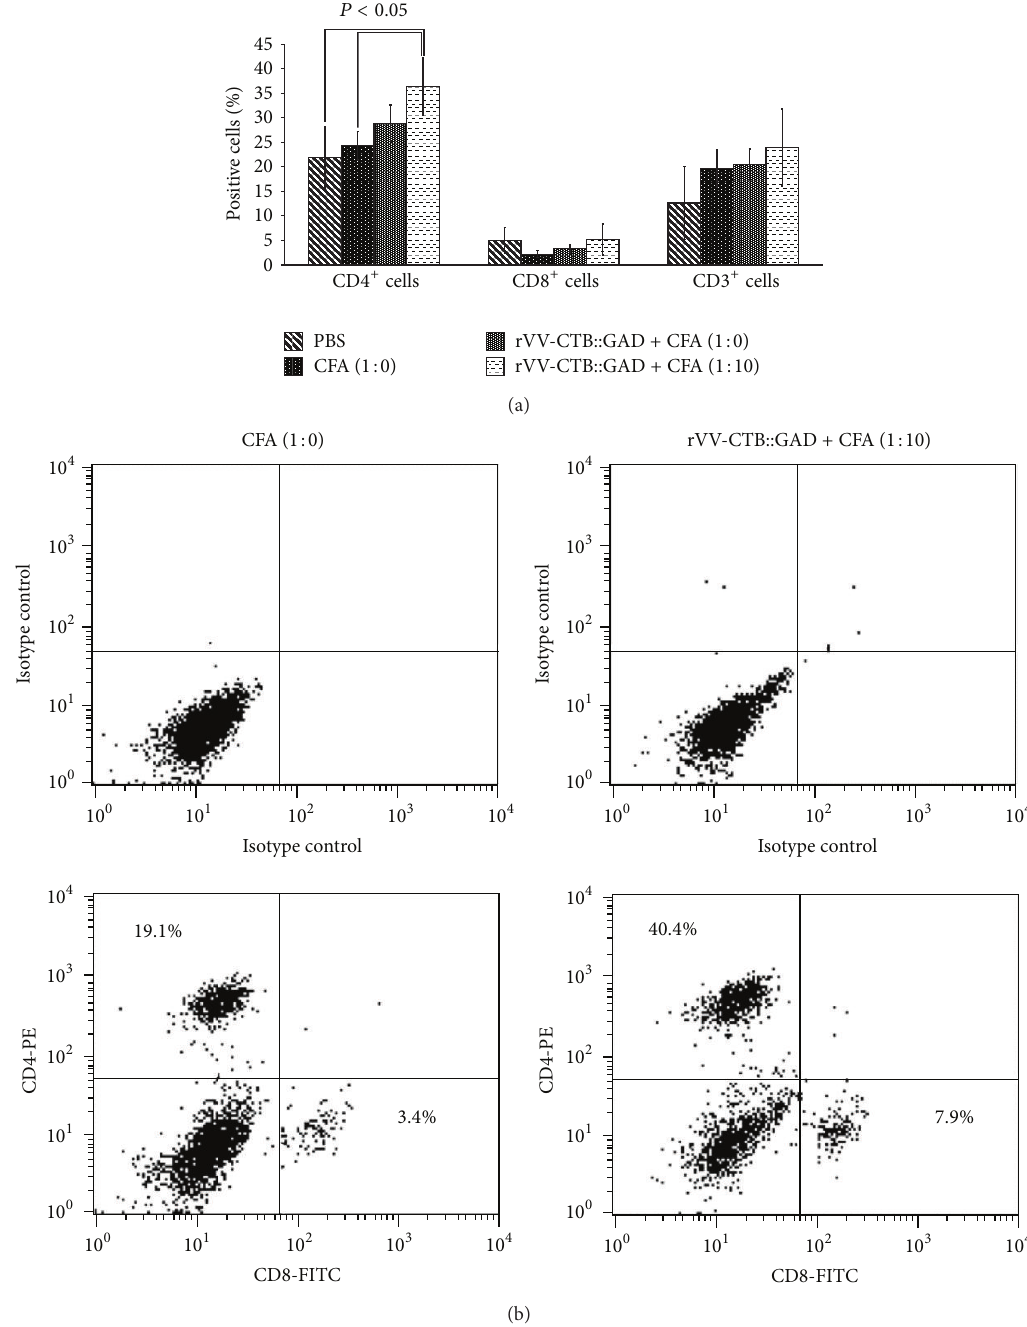
Figure 5: Analyses of splenocyte T-cell subsets. (a) Percentage of the CD3 + , CD4 + , and CD8 + T-cell subsets in splenocytes of experimental mice measured by flow cytometry. The splenocytes of the hyperglycemic PBS ( 𝑛 = 4 , median and average blood glucose 33mmol/L, median age 21wks, average 21.25 wks of age), euglycemic CFA (1:0) ( 𝑛 = 4 median 8.05 mmol/L, average 7.88 mmol/L, median/average 119wks), rVV-CTB::GAD + CFA (1:0) ( 𝑛 = 3 , median 7.7mmol/L, average 7.77mmol/L, median/average 116wks), and rVV-CTB::GAD + CFA (1:10) ( 𝑛 = 3 median 6.8mmol/L average 6.43 mmol/L, median 119wks, average 117wks) treated mice were analyzed after stimulation with GAD65. Differences between percentage of the CD4 + T-cell subsets of the gated cell population of the mice inoculated with rVV-CTB::GAD + CFA (1:10) compared to PBS and CFA(1:0) are statistically significant ( 𝑃 = 0.027 and 0.018, resp.; one-way Anova). (b) Example of the relationship between the percentage of the CD4 + and CD8 + T-cell subsets of the gated cell population of the mice inoculated with CFA (1:0) and rVV- CTB::GAD + CFA (1: 10). Cells were stained with antibodies for CD4 and CD8, as described in Section 2, and analyzed by flow cytometry. (The percentages of cells in quadrant, are shown relative to gated cells. Representative data from one mouse is